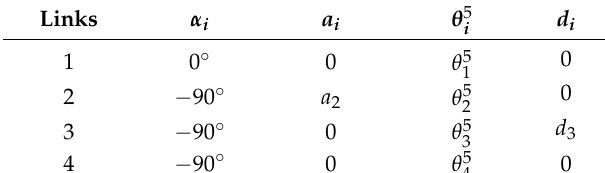
Table 5. DH parameters of the 5-DOF upper-limb exoskeleton.